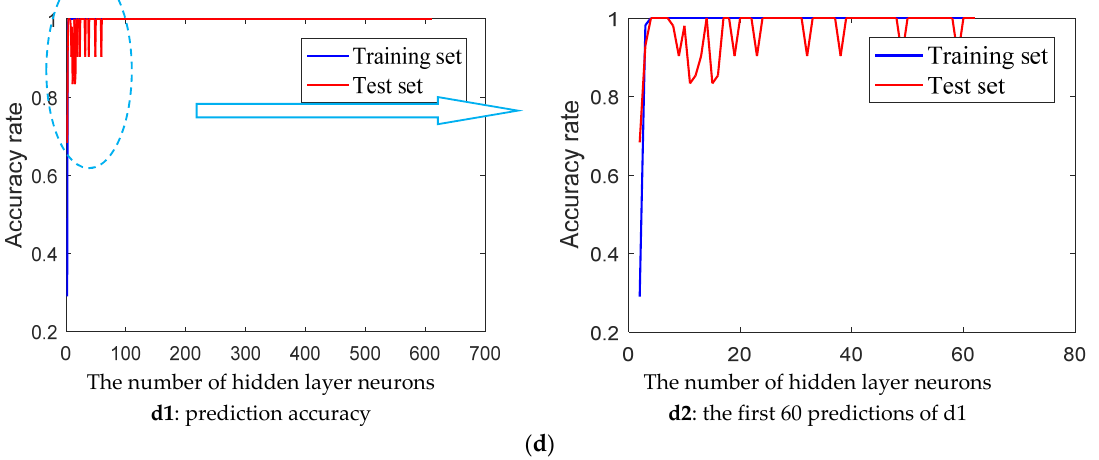
Figure 12. Prediction accuracy. ( a ) 310 training samples and 600 test samples; ( b ) 410 training samples and 500 test samples; ( c ) 510 training samples and 400 test samples; ( d ) 610 training samples and 300 test samples.